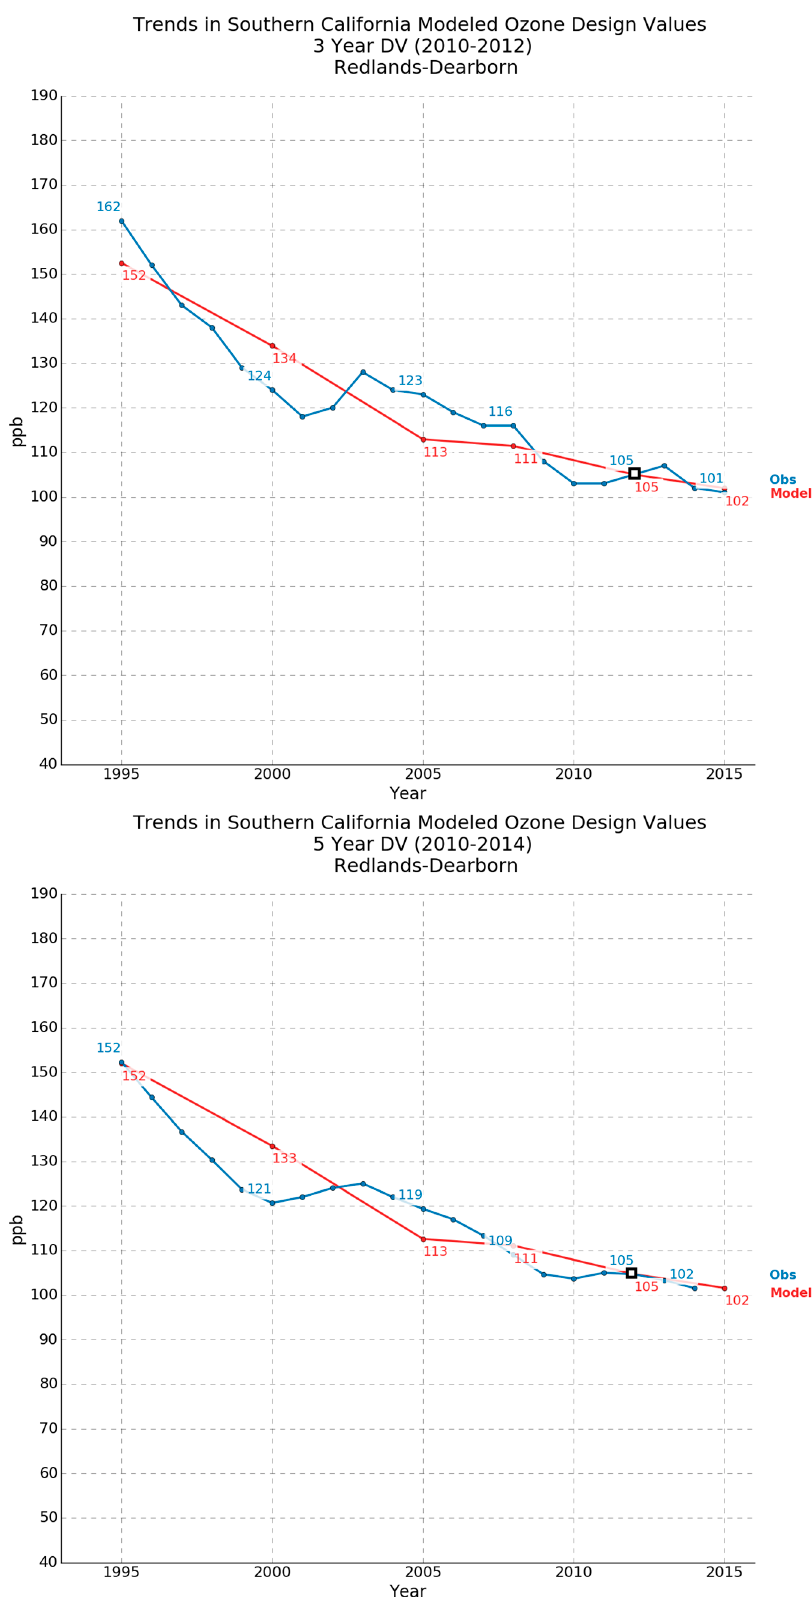
Figure 9. Modeled and observed trends in 3-year ( top ) and 5-year ( bottom ) design values at the Redlands monitor from 1995 to 2015 using the 2016 AQMP modeling database. The anchor (baseline) year for the design value calculations is 2012 (marked by the square symbol in the figures).